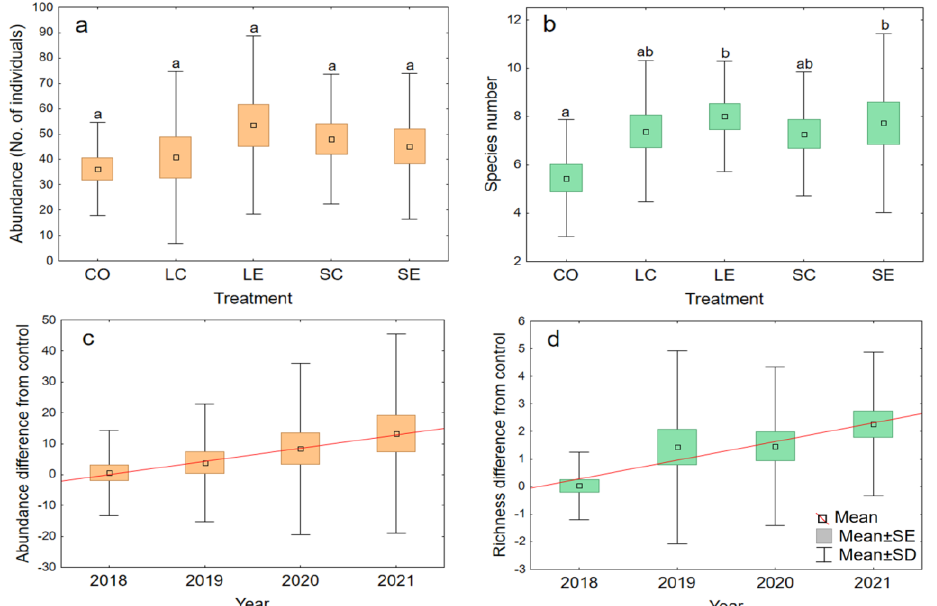
Figure 3. The effect of gap creation on spider abundance and species richness. Mean abundance ( a ) and species richness ( b ) of spiders in treatment plots over the post-implementation period (2019 − 2021); and the mean difference between control and treatment plots in abundance ( c ) and species richness ( d ) in the consecutive study years. Abbreviation of treatments as in the legend of Figure 1.